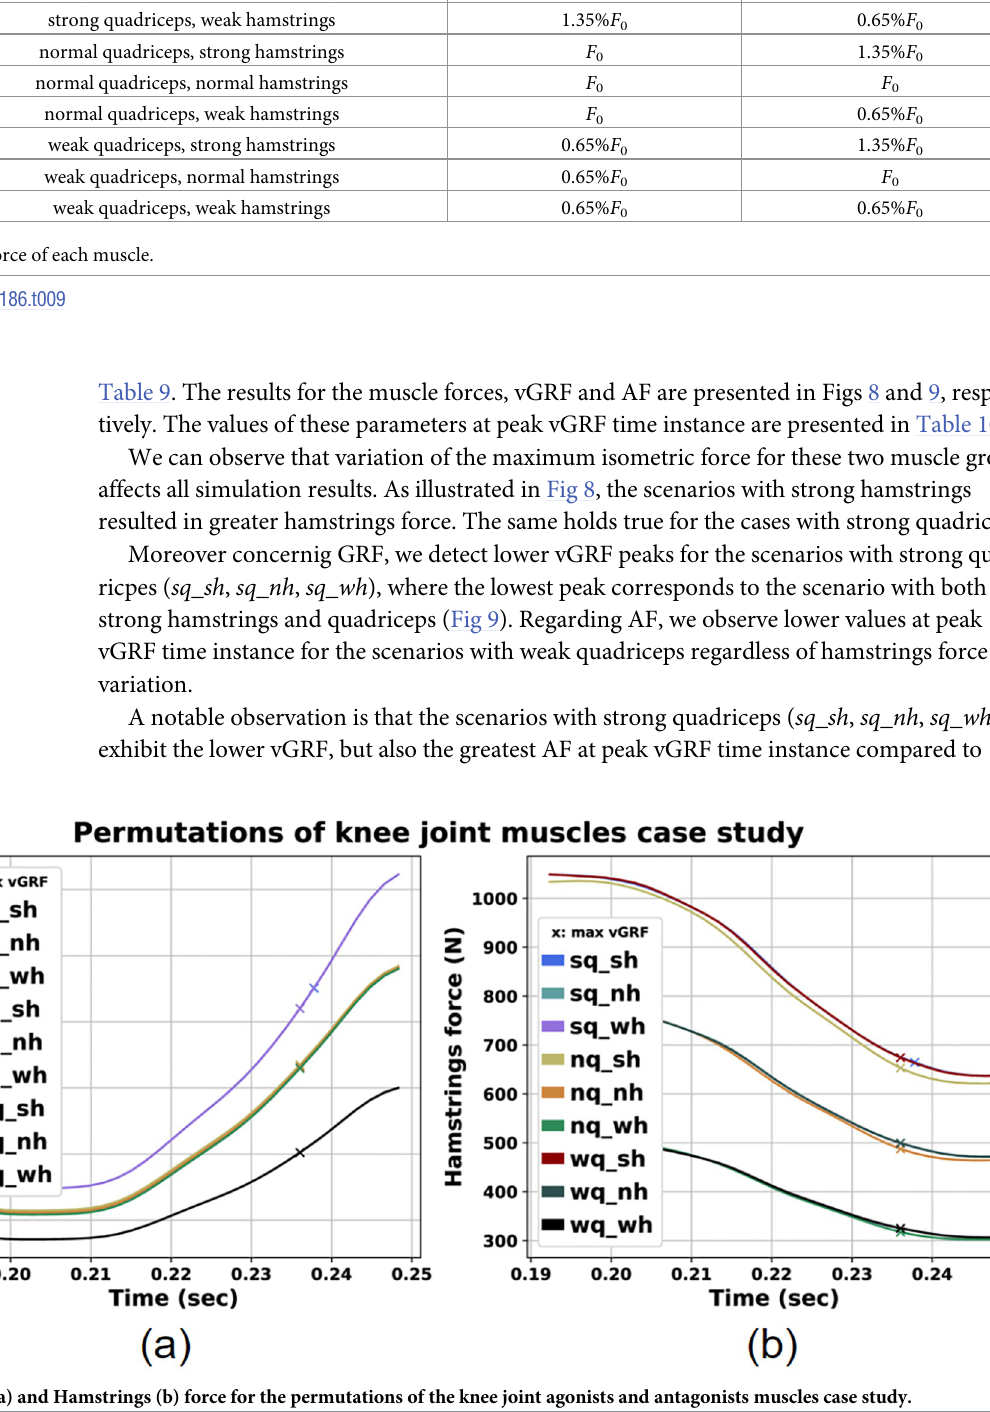
Fig 8. Quadriceps (a) and Hamstrings (b) force for the permutations of the knee joint agonists and antagonists muscles case study.